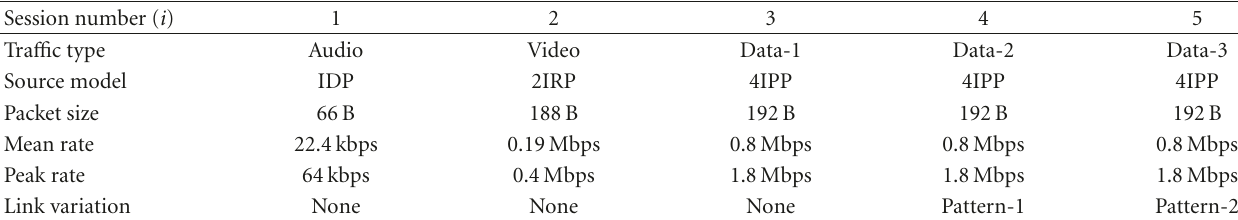
Table 1: Properties of the 5 sessions in the simulation.